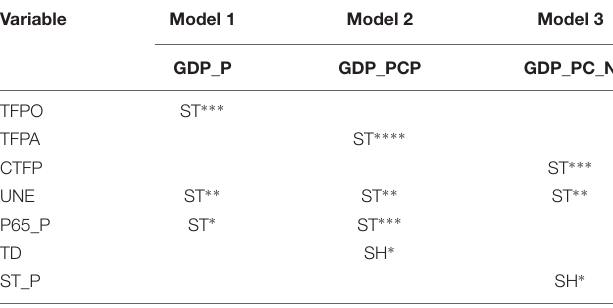
TABLE 6 | Explanatory power of factors with regard to secular